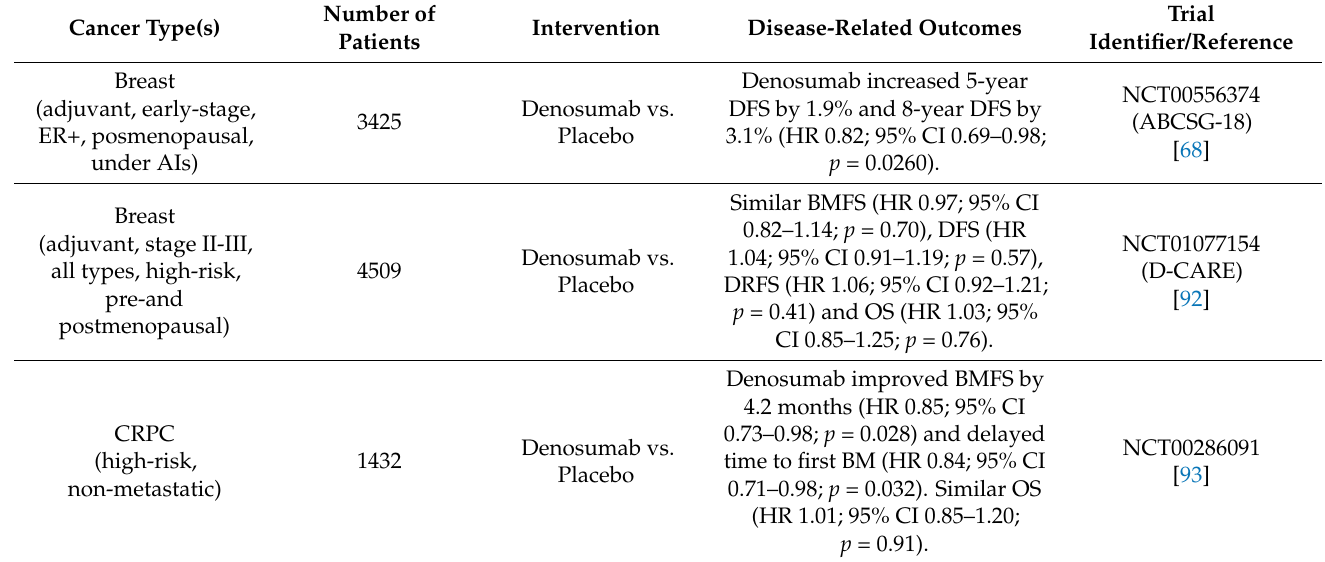
Table 3. Randomized clinical trials of adjuvant denosumab disease-modifying properties in early human